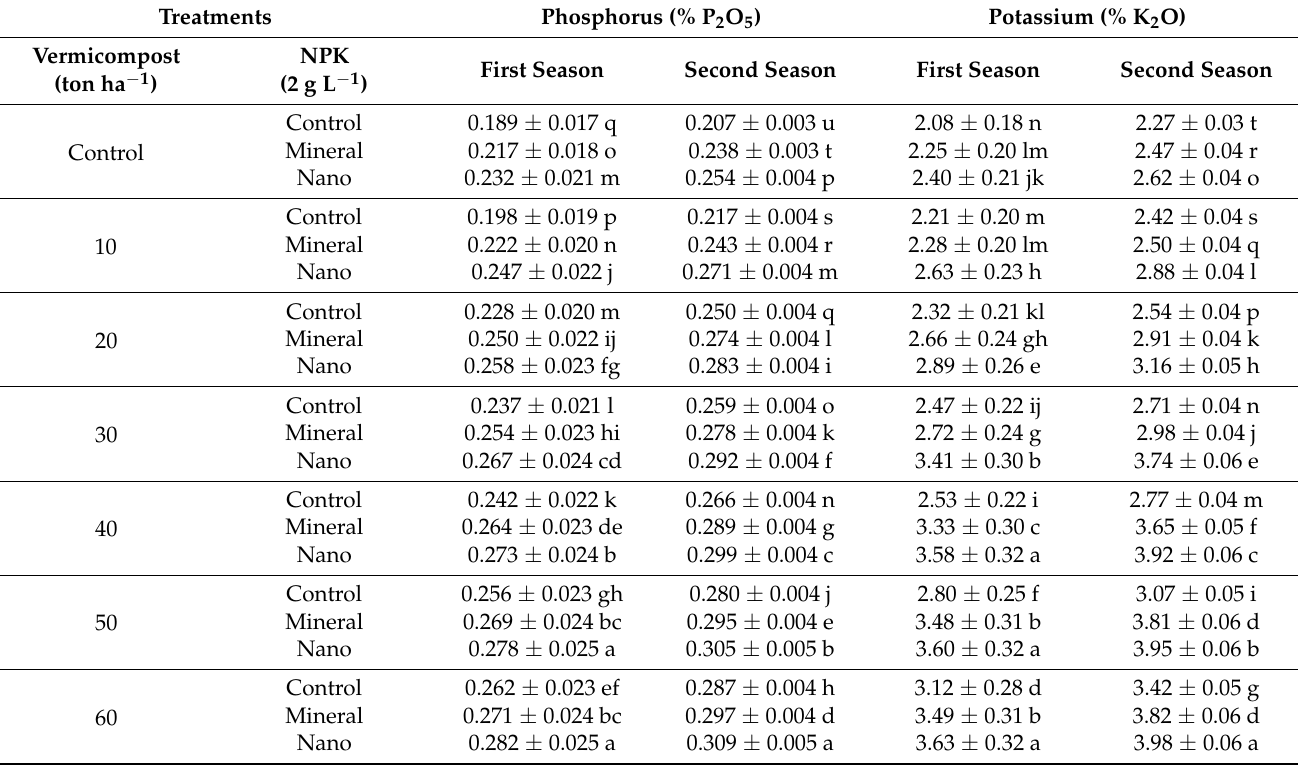
Table 9. The influence of combined treatments of vermicompost and NPK fertilization on the mean values of phosphorus content (% P 2 O 5 ) and potassium content (% K 2 O) of Moringa oleifera trees in the first and second seasons. The mean values of phosphorus content (% P 2 O 5 ) and potassium content (% K 2 O) of Moringa oleifera leaves as affected with organic fertilization and mineral fertilization combination treatments in both seasons of the